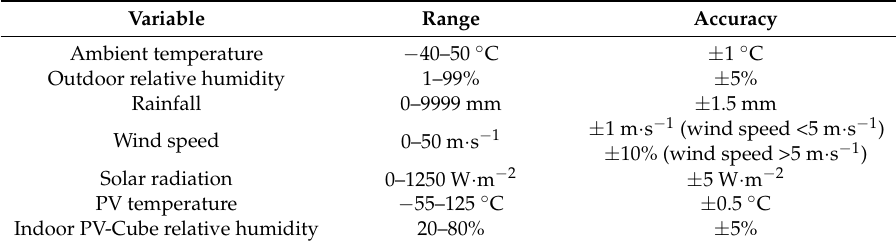
Table 1. Technical specification of the monitoring system for the BIPV